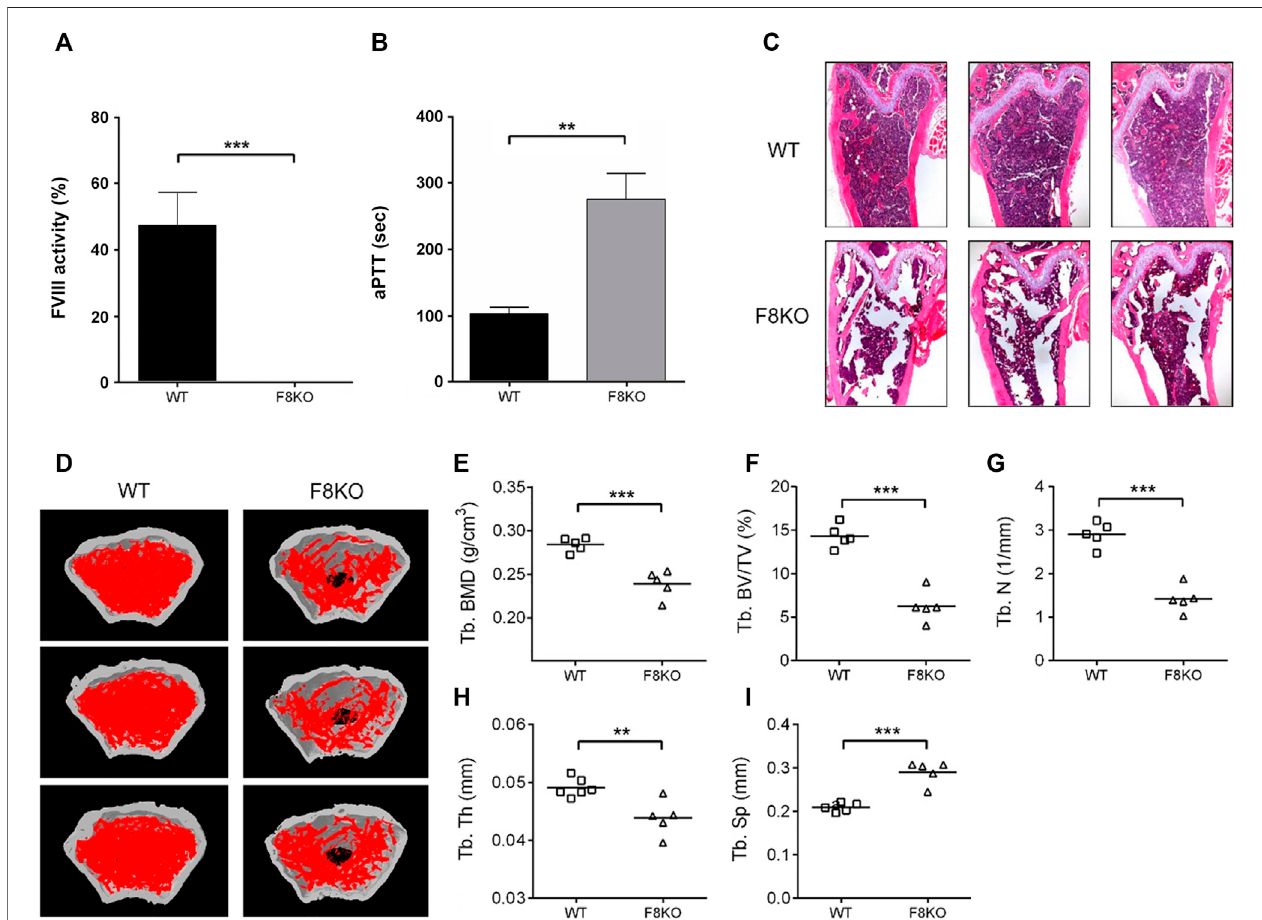
FIGURE1| Comparison ofblood coagulationactivity and femoral structures between FVIII knockoutmice (F8KO)and C57BL/6J wild-typemice (WT)at20 weeks of age. (A) Blood FVIII activity measurements of male F8KO ( n = 5) and WT ( n = 5) mice were performed using an FVIII Chromogenic Assay kit. (B) Activated partial thromboplastintime (aPTT)testsofmaleF8KO ( n =5)andWT( n =5)micewereperformedusingaCoag DxAnalyzer. (C) Hematoxylinand eosin(H&E)stainingoffemur tissue sections of male F8KO and WT mice for bone histopathological analysis. (D) Microcomputed tomography ( μ -CT) analysis was performed to characterize femoral architectural structures. Representative images of femur trabecular morphology plotted in red. The quantitative μ -CT results of (E) trabecular bone mineral density (Tb.BMD), (F) trabecular bone volume/total volume (Tb.BV/TV), (G) trabecular number (Tb.N), (H) trabecular thickness (Tb.Th), and (I) trabecular separation (Tb.Sp) were shown as indicated (** p < 0.01, *** p < 0.001 vs. WT group).